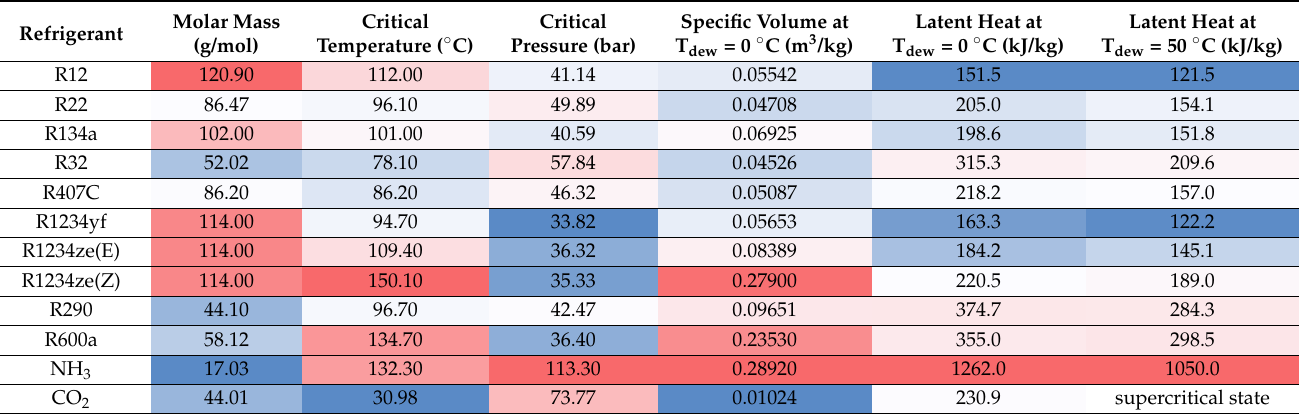
Table 8. Thermodynamic properties of the studied